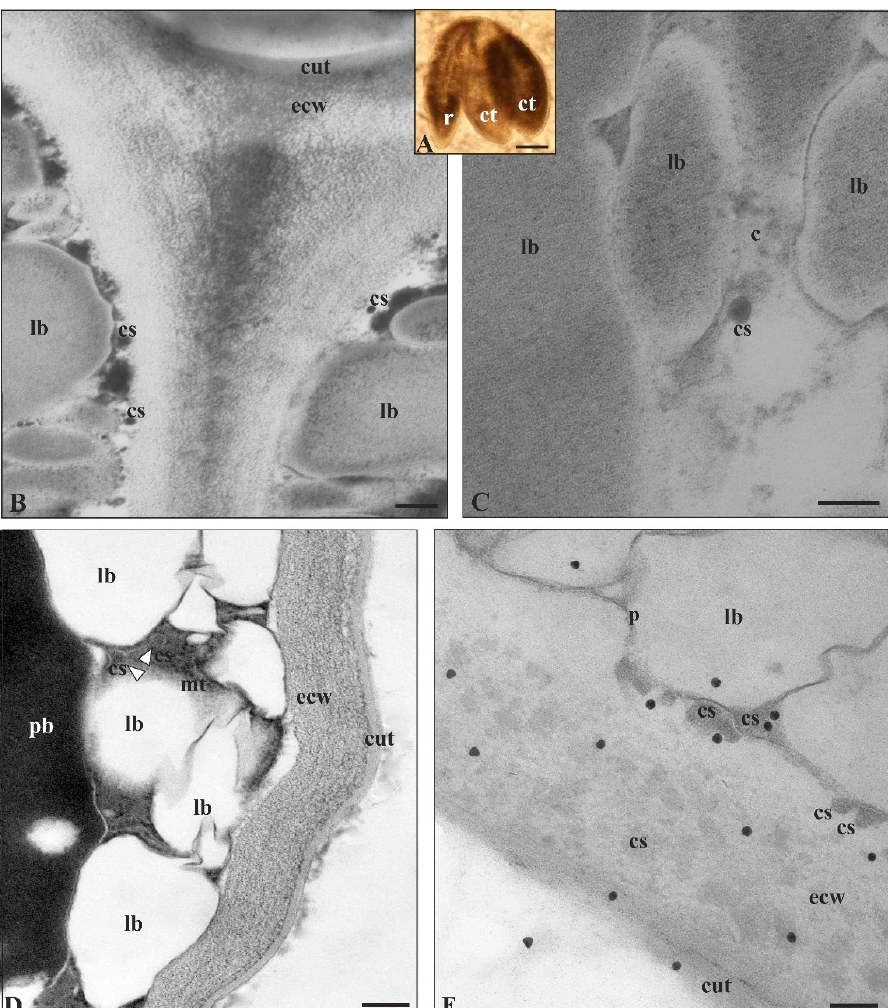
Figure 7. Cutinsomes of A. thaliana embryo cotyledon epidermis. ( A ) Isolated mature embryo embedded in resin with well-developed cotyledons ( B , D ) whose surface is already covered with clearly visible cuticle. ( B – E ) Cutinsomes formed in cytoplasm ( E ) moving to the plasmalemma and external cell wall where they undergo fusion and build cuticle. ( E ) Cutinsomes labeled (20 nm gold grains) after the immunogold reaction using specific antibodies in the external cell wall and cuticle. ( E ) Gold grains are often situated at cutinsomes or at the places where cutinsomes are invisible due to their disintegration, yet their components are still recognized by antibodies [31,66,68]. Moreover, cutinsomes that are visible but not labeled may result from masking their epitopes by other cell wall or cuticle components [84–86]. TEM sections fixed ( B , C ) with glutaraldehyde and OsO 4 —cutinsomes seen as dark, electron dense structure, and ( D ) without OsO 4 —cutinsomes hardly visible as slightly gray structures (white triangle) against electron-dense cytoplasm; c, cytoplasm; cs, cutinsome; ct, cotyledon; cut, cuticle; ecw, external cell wall; lb, lipid body; mt, microtubule; p, plasmalemma; pb, protein body; r, radicle; Bars, ( A ) 100 µ m, ( B , D ) 200 nm, ( C , E ) 100